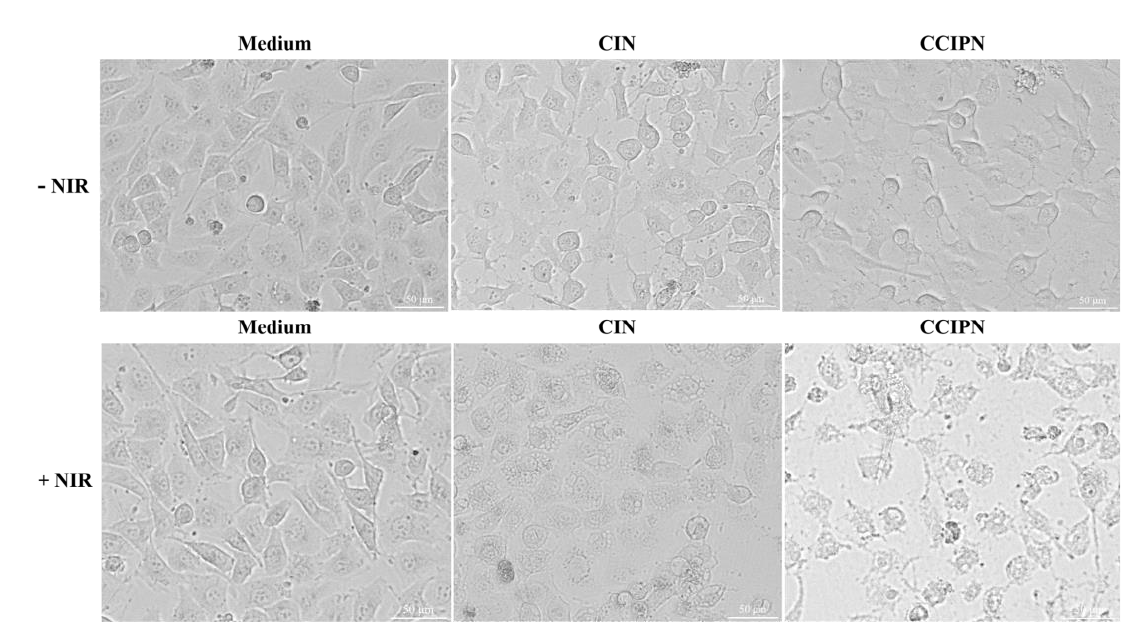
Figure 13. HUVECs morphologies under different treatment conditions.